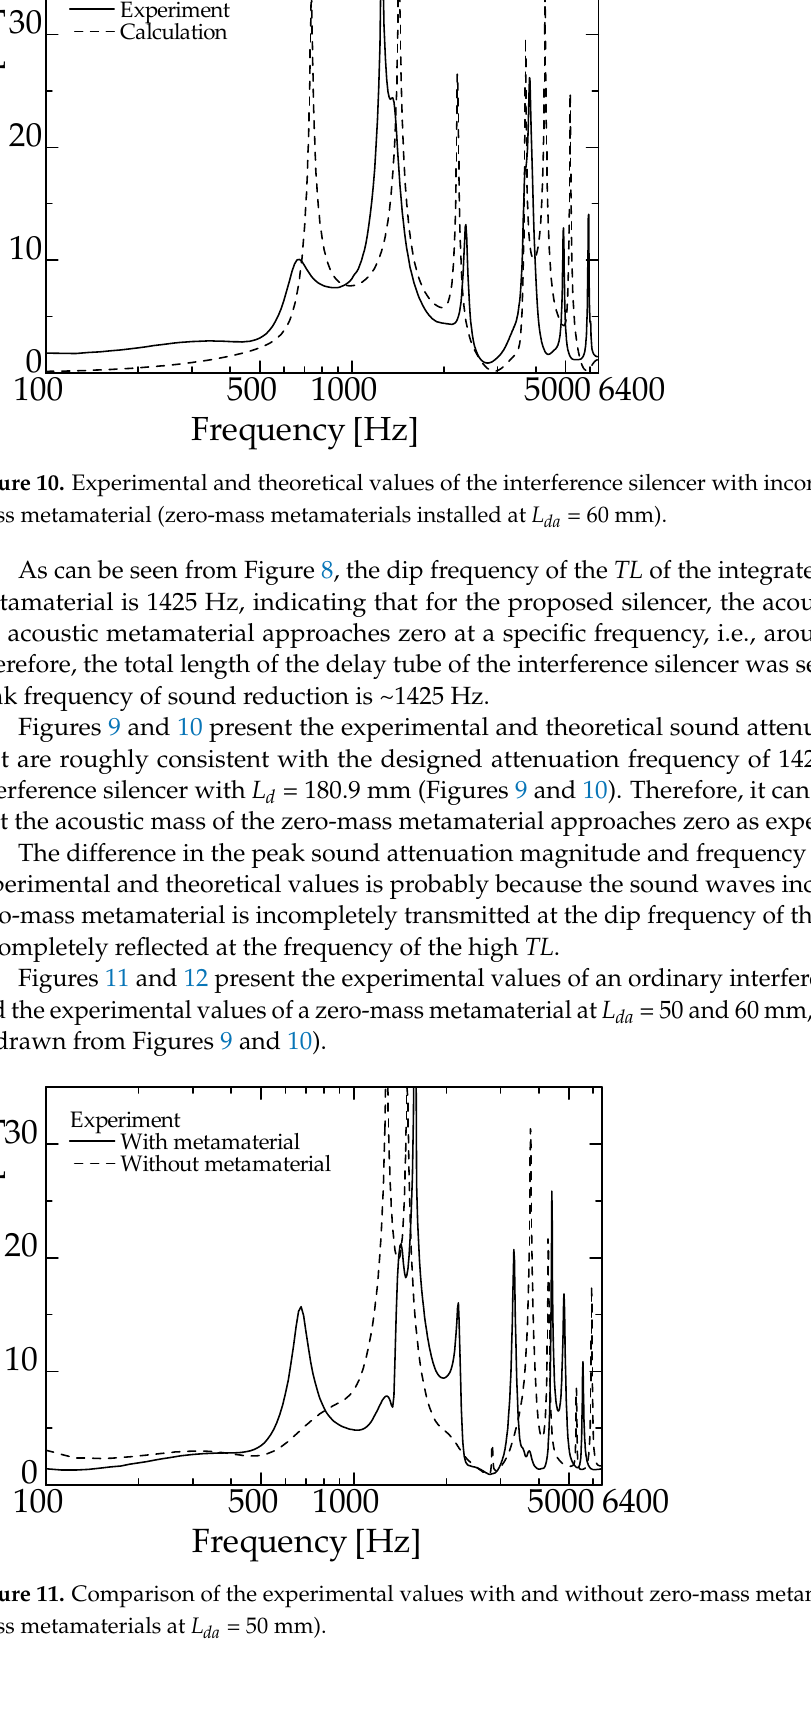
mass metamaterials at L da = 50 mm).